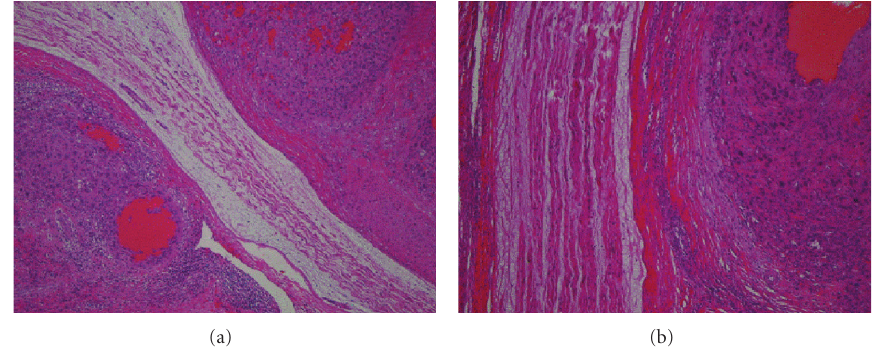
Figure 3: (a) Histological appearance of postoperative section showing that no tumor cell is infiltrated into the nerve, but (b) the pseudocapsule of the tumor is transitioning to the perineural sheath of the median nerve.